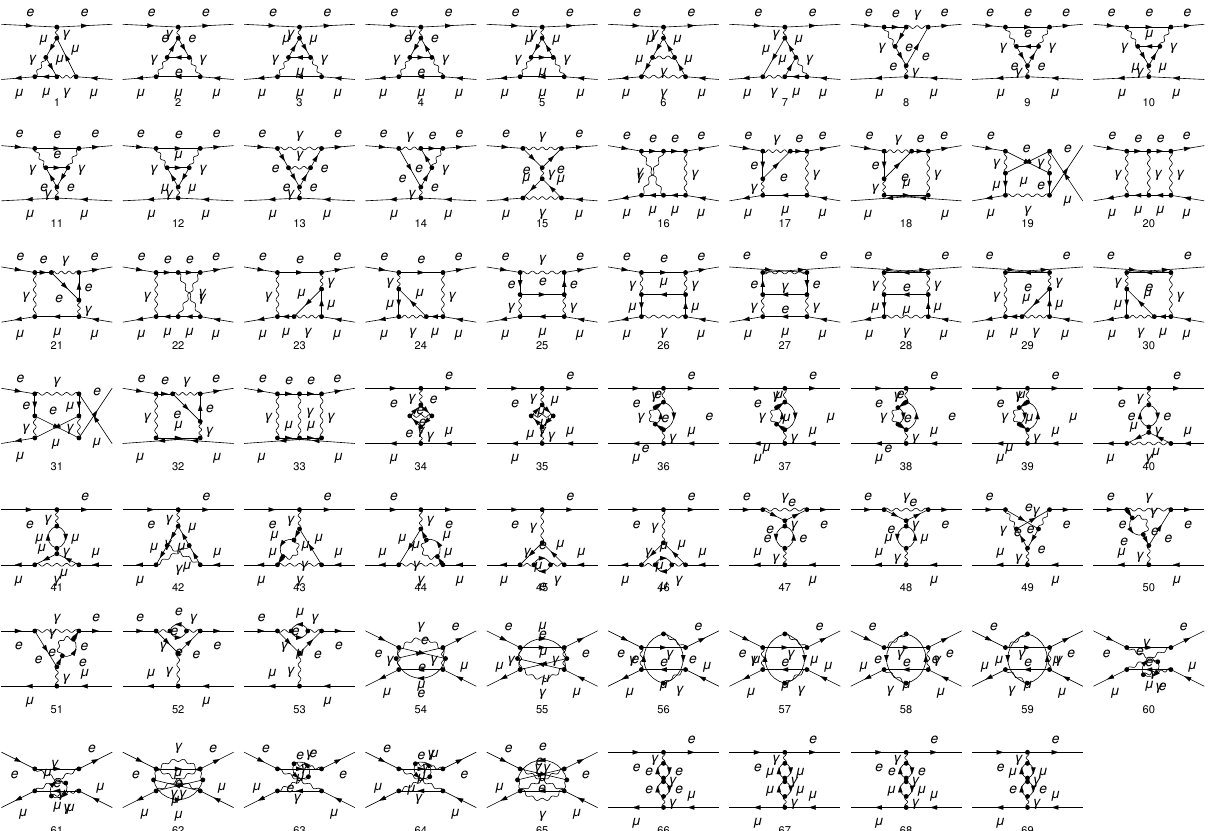
Figure 1. Two-loop diagrams contributing the QED NNLO amplitude for the µ e